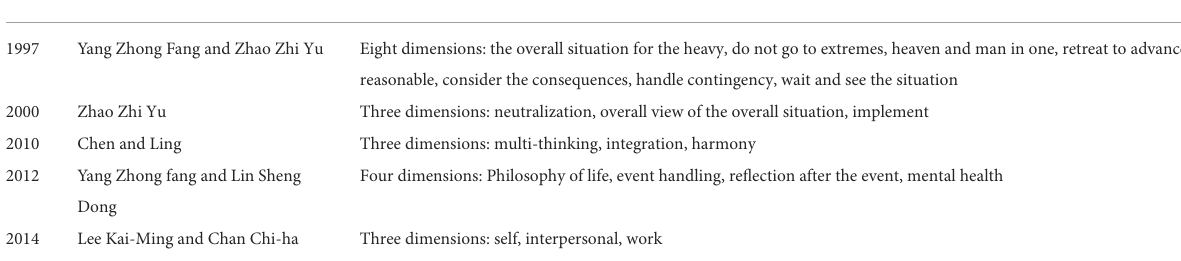
TABLE 1 The representative scale of mean